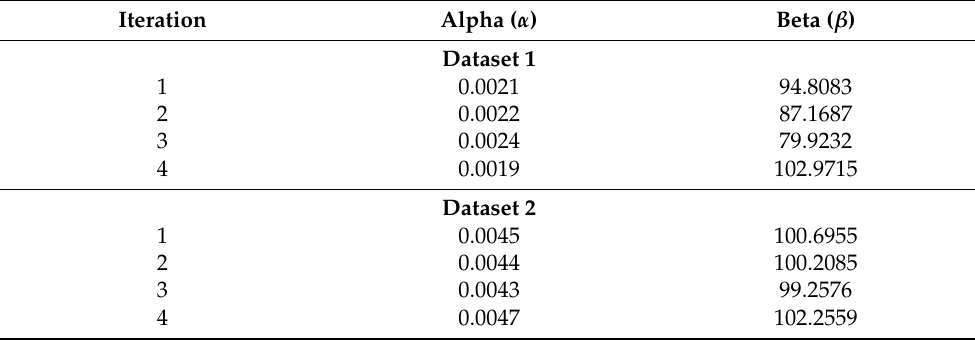
Table 4. Optimisation of the hyperparameters α and β using the Bayesian evidence framework. The hyperparameters α and β control other parameters (weight and biases) of the multilayer perceptron (MLP) network. The hyperparameters were estimated four